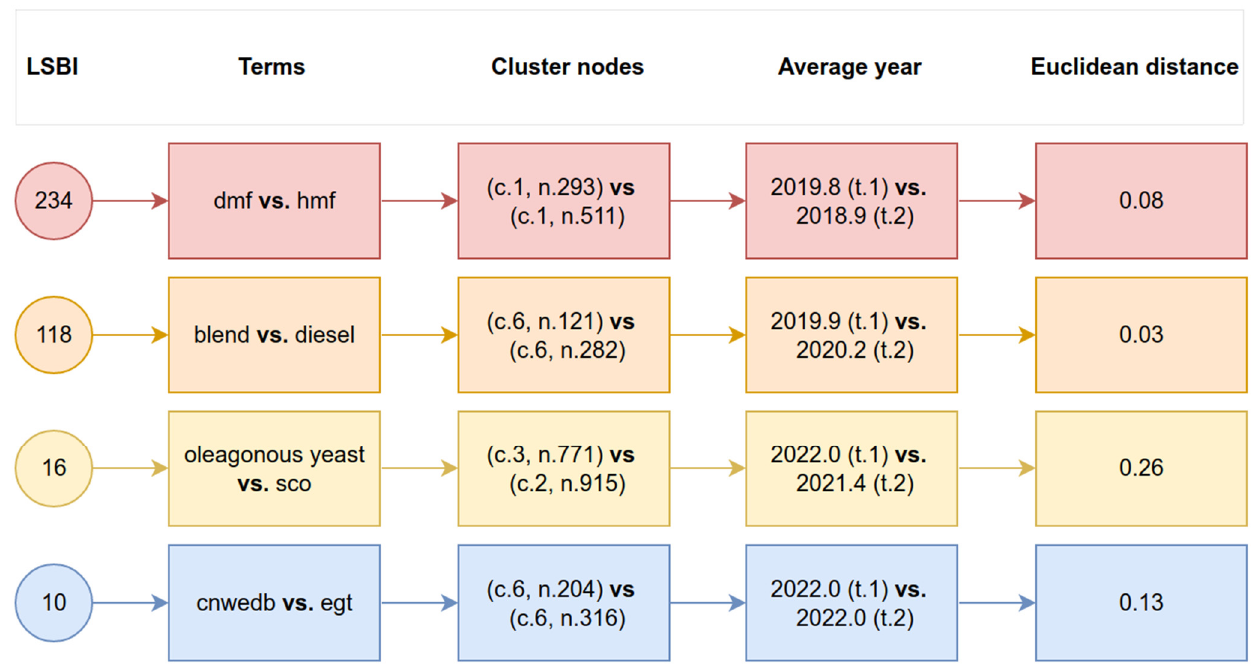
Figure 9. Relevant data from Table 1 sorted by LSBI.